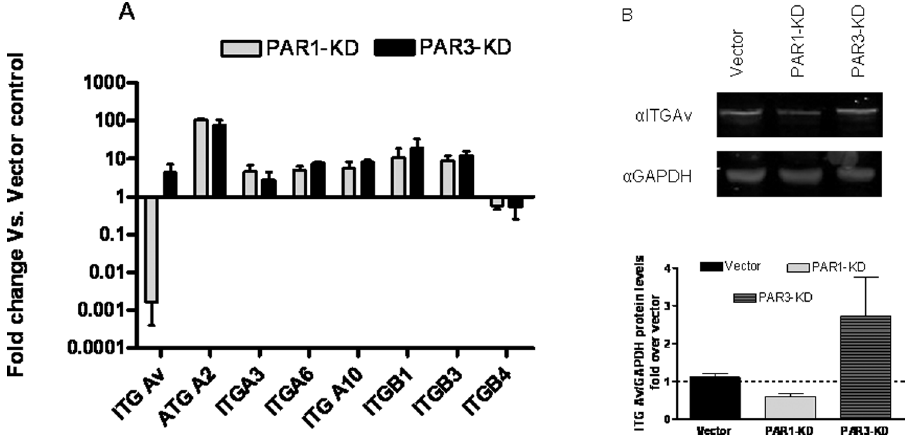
Figure 4. Integrins’ mRNAs levels of vector-controls and PAR-1 or -3 KD cells. A- Vector-control, PAR-1 or -3 KD cells were assayed for mRNA levels of the designated integrins and normalized to GAPDH mRNA levels. The results are presented as fold difference of respective KDs mRNA levels to those of vector-controls. The results represent mean 6 SE of at least 3 independent experiments. B-Representative western blot analysis of ITG a V and GAPDH in Vector-Control, PAR-1 or -3 KD cells. Lowe panel-quantification of protein expression from three different western blots with 3 different cell lysates for each sample. The results represent mean 6 SE of 3 independent experiments.